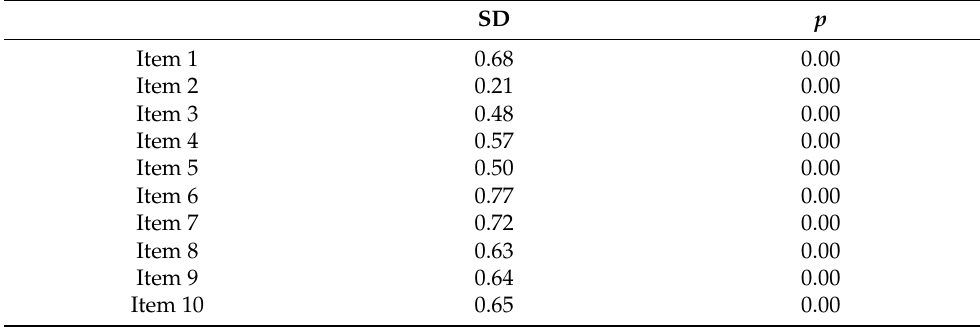
Table 3. Significance level with Student t-test and standard deviations in pre- and post-training evaluation.